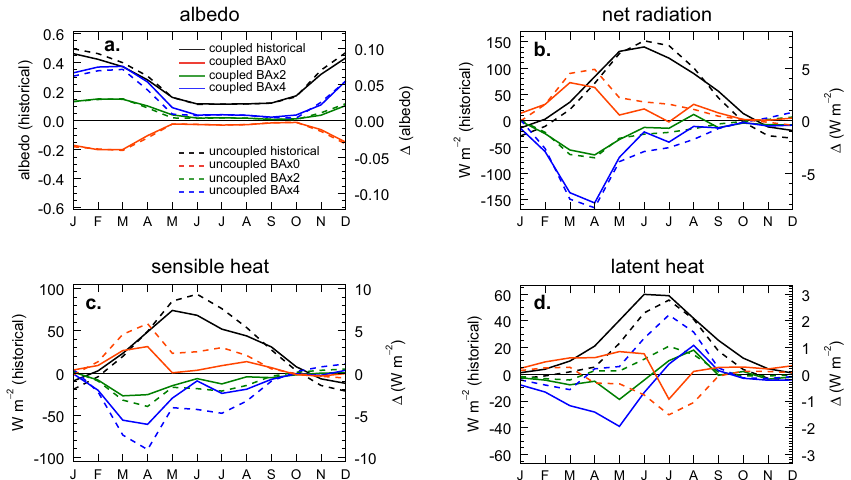
Fig. 5. Mean monthly historical (BA × 1) and changes to energy budgets under altered burn area scenarios for coupled and uncoupled simulations. Historical values are on left-hand axes, and anomalies from BA × 1 on right-hand axes.